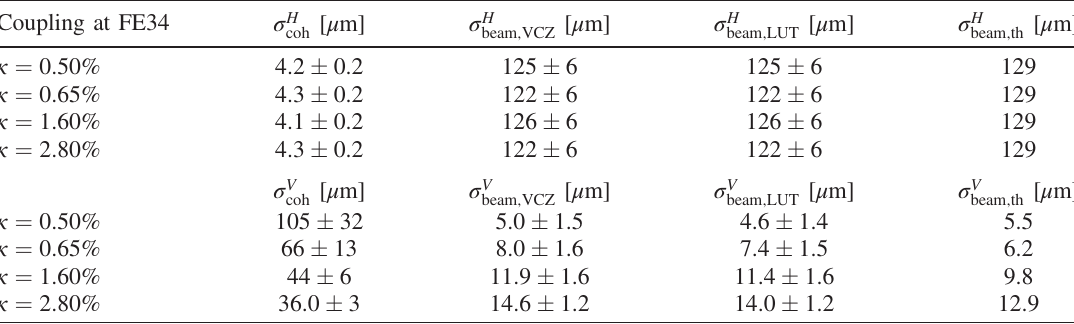
coh , horizontal and vertical electron beam sizes obtained beam ; VCZ , and expected values σ H;V based on independent pinhole and LOCO beam ; LUT beam ; th